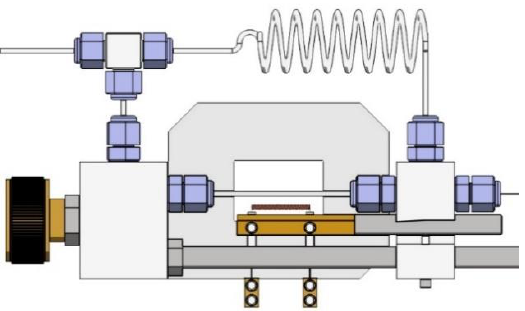
Figure 10. High-pressure holder (Aarhus, Denmark) for the samples for in situ synchrotron data Figure 10. measurement.